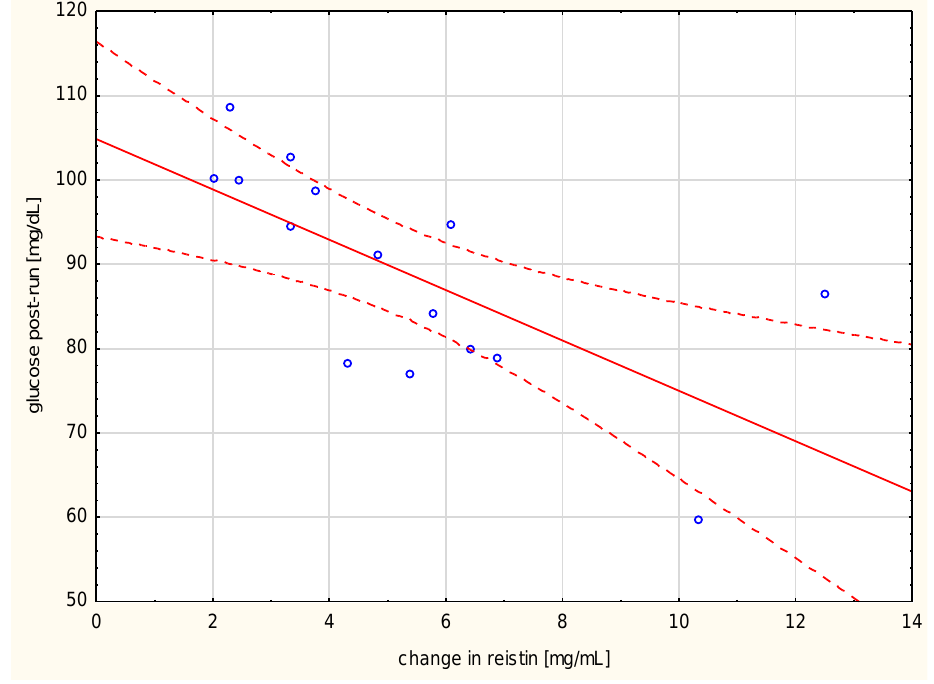
Figure 2. Correlation of change in resistin levels with post-run glucose values ( r = –0.742, p < 0.001).